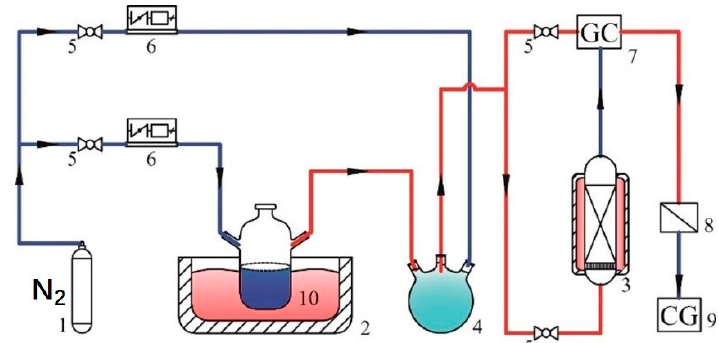
Figure 2. Schematic flowchart of the experimental set up: (1) nitrogen cylinder, (2) thermostat water bath, (3) constant temperature adsorption columns, (4) mix chamber, (5) globe valves, (6) mass flow controllers, (7) gas chromatography, (8) exhaust gas treatment tank, (9) clean gas (10) VOCs mixture generator.